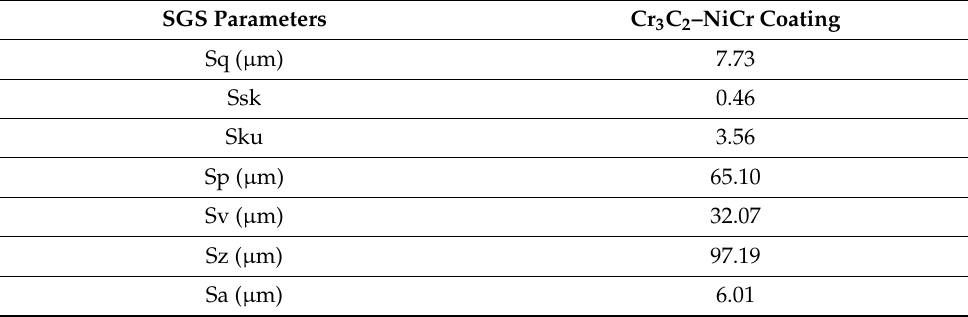
Table 9. Parameters of the SGS after laser alloying (sample 1).